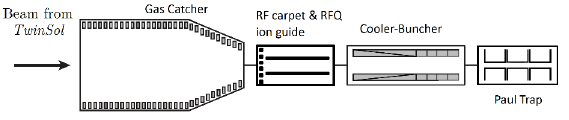
Figure 6. Schematic dagram of the ion trap "St. Benedict".